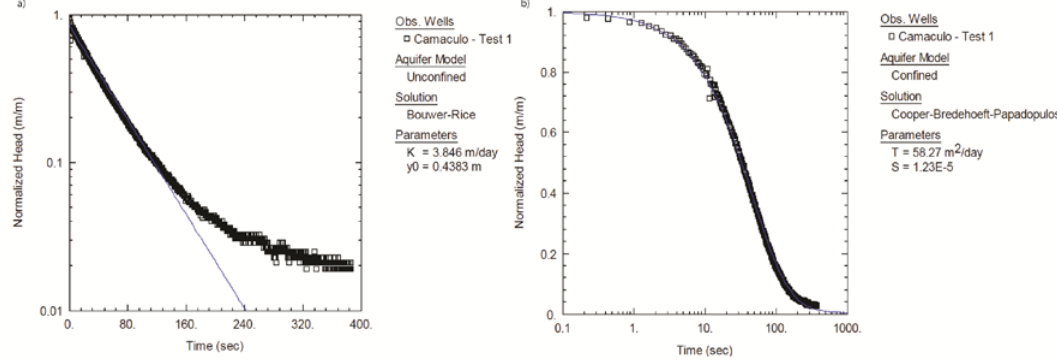
Figure 6. Data fit of test 1 to Bouwer and Rice ( a ) and Cooper et al. ( b ) solutions in the Cuhare B borehole [22].